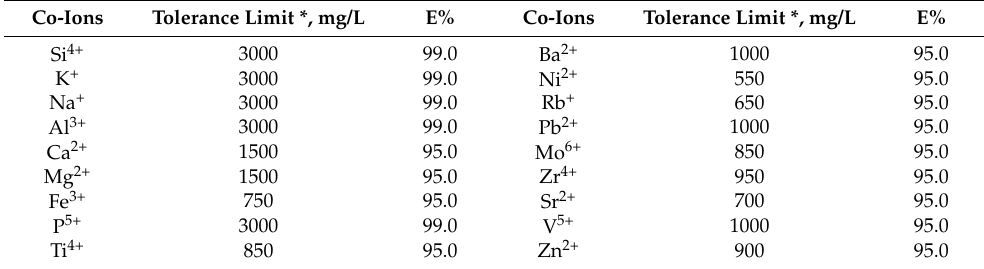
Table 4. The influence of co-ions on U(VI) ion extraction by HTIP chelating ligand. Co-Ions Tolerance Limit *, mg/L E% Co-Ions Tolerance Limit *, mg/L E% Si 4+ 3000 99.0 Ba 2+ 99.0 Ni 2+ 550 95.0 Na + 99.0 Rb + 99.0 750 95.0 Sr 2+ 700 95.0 P 5+ 99.0